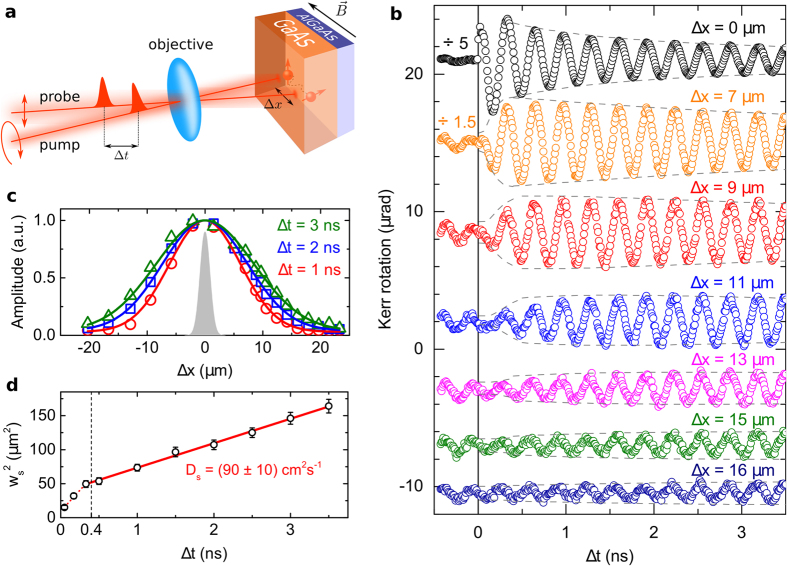
Measurement of the spin life-time and spin diffusion coefficient.(a) A sketch of the spatially resolved pump-and-probe optical experiment. Circularly polarized pump and linearly polarized probe pulses are relatively time-delayed by Δt and focused to 2 μm sized spots (full width at half maximum). The spots can be spatially separated by Δx by tilting the incident pump beam. The magnetic field B is applied in-plane along the pump-probe separation direction. The sample was kept at temperature 10 K. (b) Kerr rotation dynamics measured by the spatially resolved pump and probe technique for several Δx. The Δx-dependent increase of the signal in time is a signature of diffusive spin-transport. The non-oscillatory envelopes (gray dashed curves) are calculated from Eq. 1 using the transient  and intrinsic steady-state Ds for Δt < 0.4 ns and Δt > 0.4 ns, respectively. The data were vertically shifted and upper two curves were divided by indicated factors for clarity. (c) The spatial Gaussian dependence of the amplitude of the oscillatory Kerr signal at Δt = 1, 2 and 3 ns (marked by circles, squares and triangles, respectively) and the corresponding fits using Eq. 1. The spatial profile of the pump spot is depicted by the grey area. (d) Δt dependence of the half-width of the spatial Gaussian profile of the amplitude of the oscillatory Kerr signal.